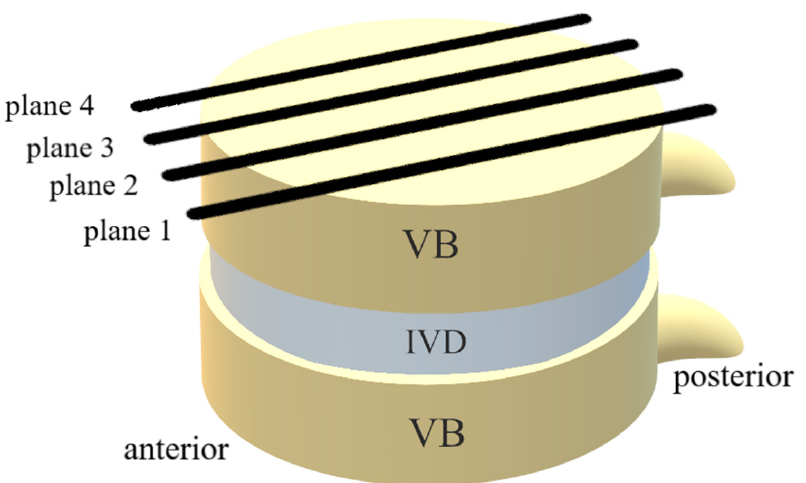
Figure 3. Scheme of the distribution of sagittal MR planes through the vertebral bodies (VB) and intervertebral discs (IVD). Planes 1 and 2 are located through the left part, planes 3 and 4 through the right part.